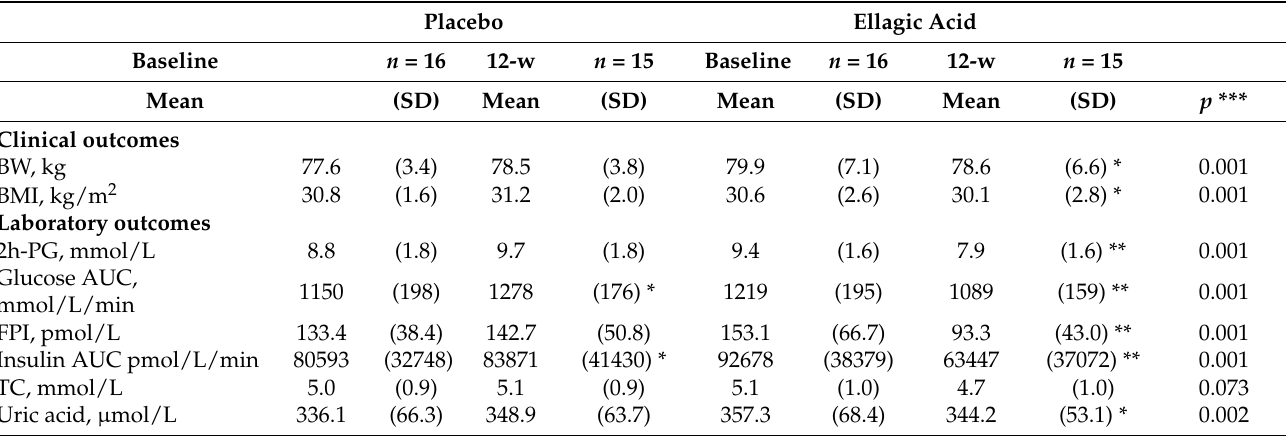
Table 3. Secondary outcomes at baseline and at the end of the intervention.